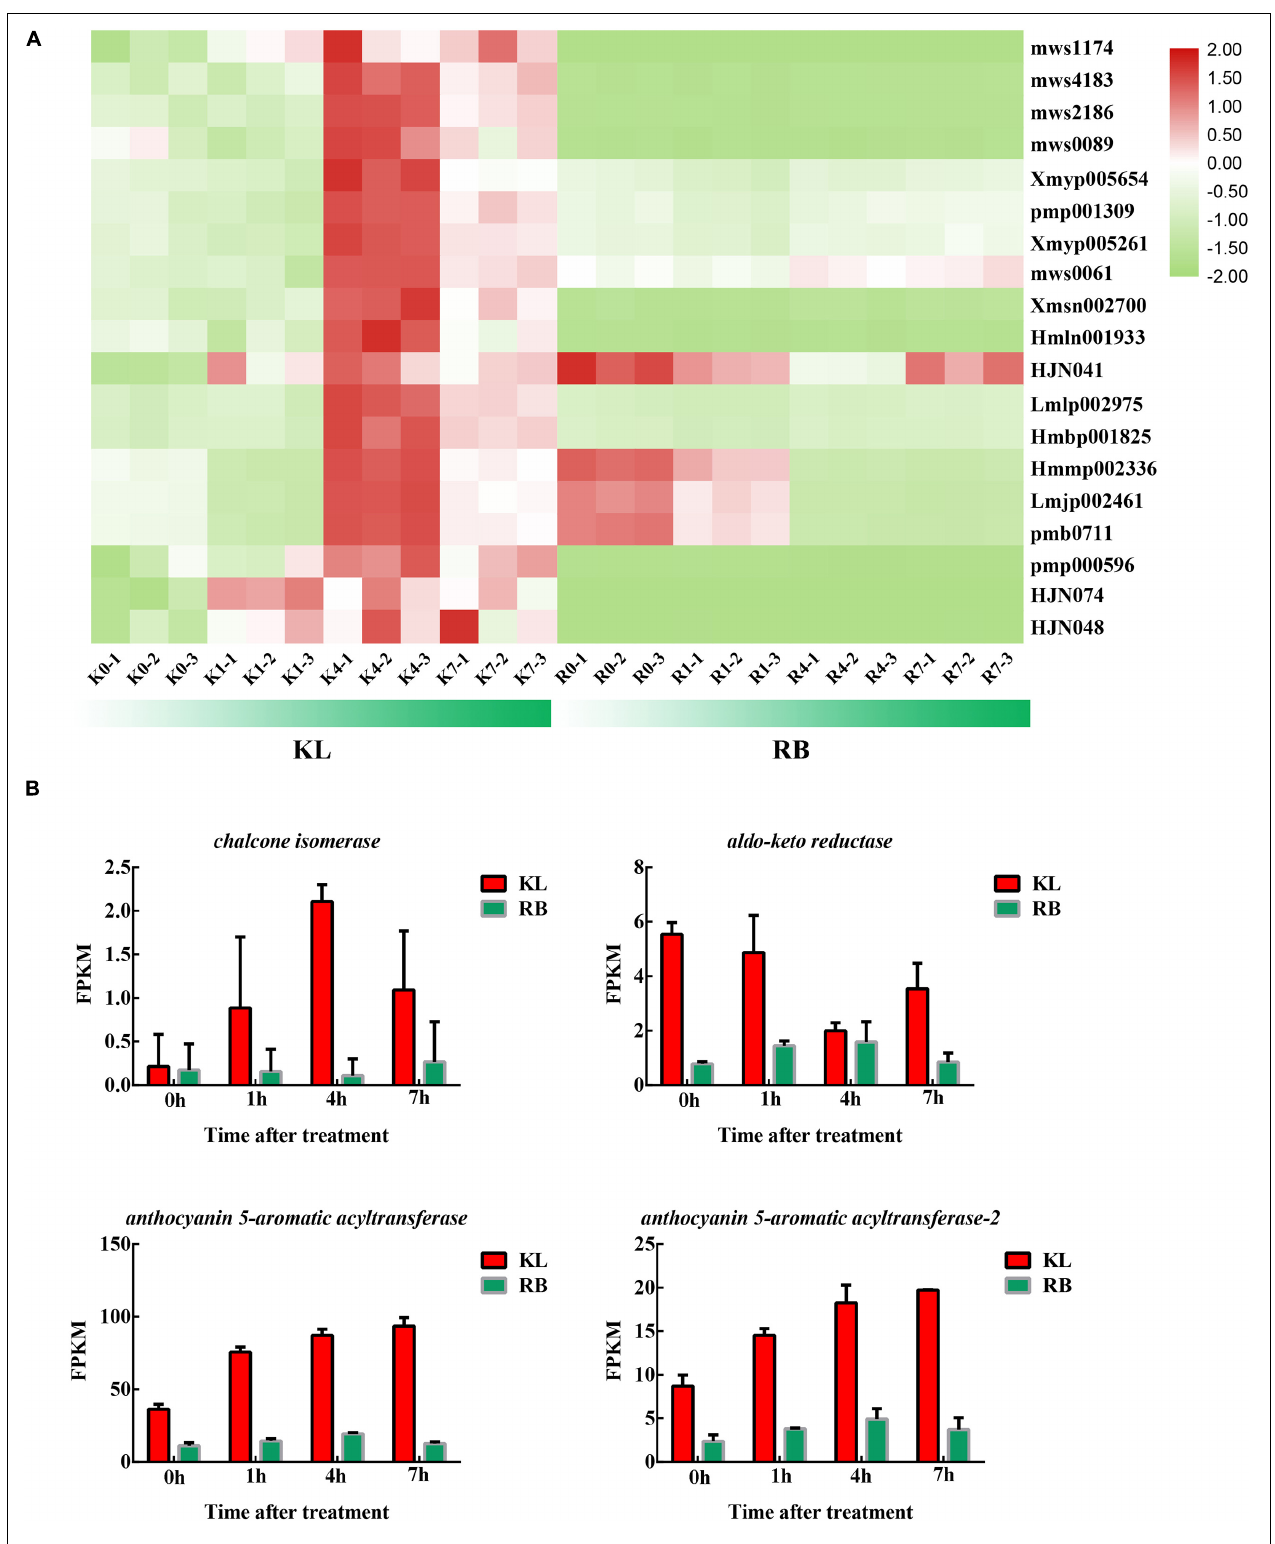
FIGURE 8 | The DEMs and DEGs involved in the flavonoid metabolism pathway. (A) Heat map of flavonoids that specifically accumulated in the KL genotype. (B) Candidate DEGs involved in the flavonoid metabolism pathway.